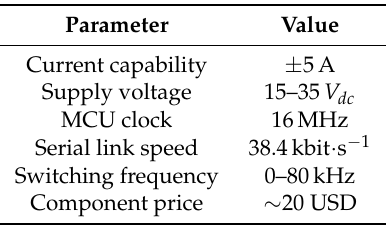
Figure 3. ( Top ) Schematic block diagram of the CCB. Only the main digital and analogue signal pathways are shown; ( Bottom ) The CCB mounted in a protective plastic casing. Serial communication was achieved using an additional serial to USB converter module, (not shown). Table 2. General CCB